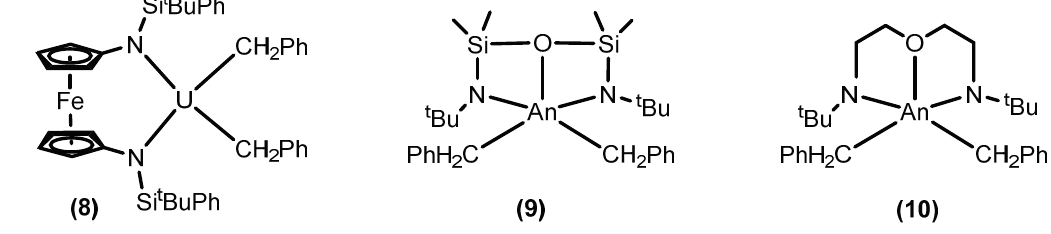
Figure 4. Actinide complexes 8 – 10 used as catalysts for hydroamination reactions